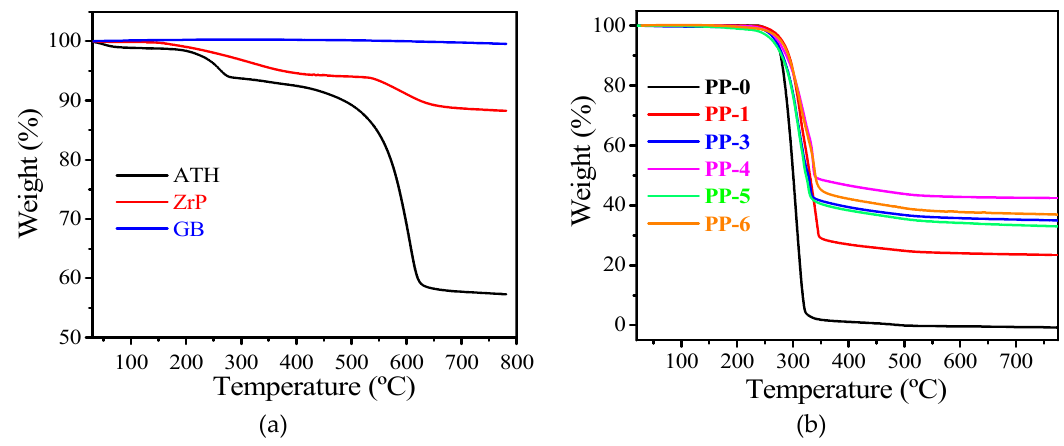
Figure 3. Thermogravimetric analysis (TGA) curves of ( a ) additives and ( b ) PP composites.